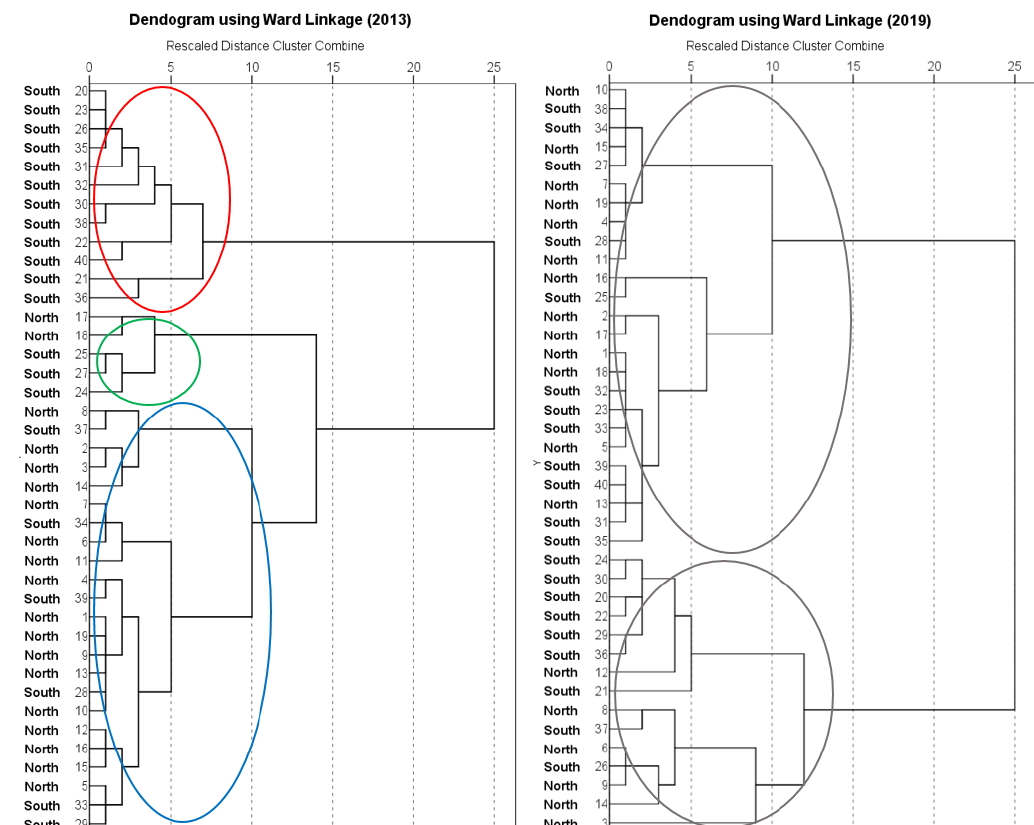
Figure 7. Ward’s dendogram based on the location of sampling sites before (2013) and after (2019) the construction of the sewerage network.